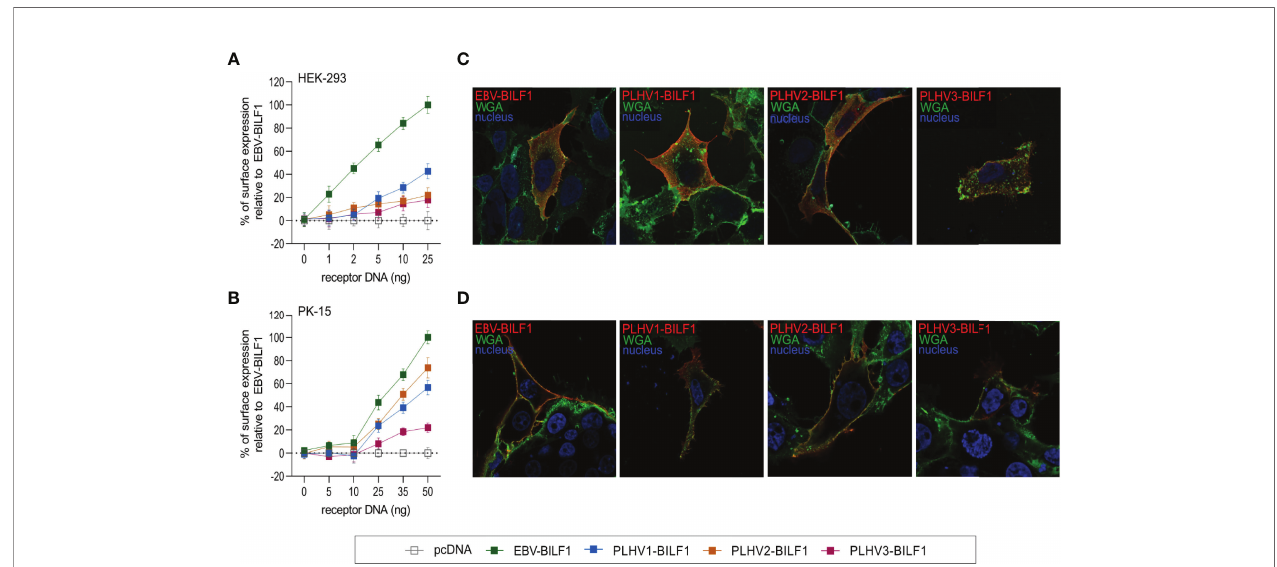
FIGURE 1 | Cell surface expression of BILF1 receptors in HEK-293 and PK-15 cells. (A, B) Graphs show surface expression of PLHV BILF1 orthologues compared to EBV-BILF1 expression using cell-based ELISA at increasing concentrations of receptor DNA in (A) HEK-293 and (B) PK-15 cells (values are mean ± SEM; n = 3). (C, D) Representative microscopy images show the localization of BILF1 orthologues (red) at the cell surface determined by co-localization with WGA conjugated to Alexa 488 (green) in (C) HEK-293 and (D) PK-15 cells. Nuclei are stained with Hoechst 33342 stain (blue). Images were taken with 63 × oil immersion plan ‐ apochromat objective.